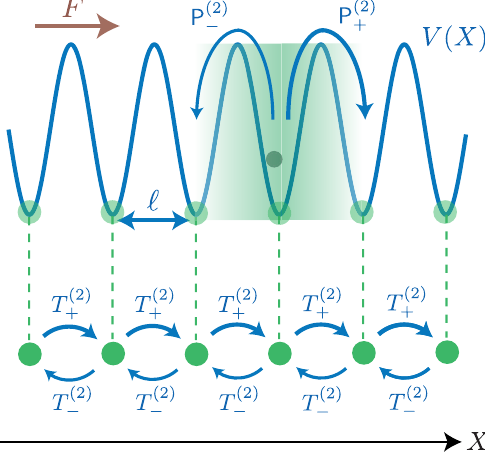
FIG. 11. Coarse-graining procedure from a continuous Lange- vin process (top) to a discrete Markov process (bottom). The horizonal axis denotes either a chemical coordinate, which quantifies the progress of a chemical reaction, or a position coordinate, which quantifies the position of a molecular motor. In the Langevin description, this coordinate is described by the position of a Brownian particle (gray circle) moving in a periodic potential V ð X Þ of period l (blue curve) and driven by an external bias F ¼ Δ G= l − F . In the discrete process, this coordinate mech is described by the state of a Markov jump process with stepping rates k and k − , which are related to stopping times and passage þ 2 Þ 2 Þ probabilities of entropy production through k ¼ P ð h 1 =T ð i þ þ þ and k − ¼ P ð 2 Þ − h 1 =T ð 2 Þ − i . Our coarse-graining procedure corre- sponds to a partitioning of the coordinate axis into intervals (green shaded areas) centered on the minima of the potential (dashed